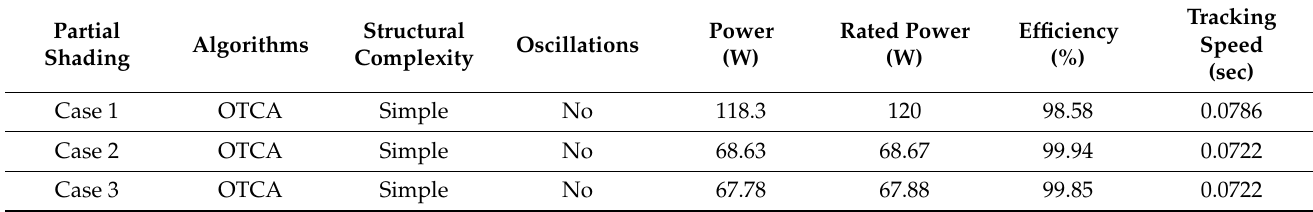
Table 11. Performance comparison of OTCA for 2S2P PV system for all test cases.